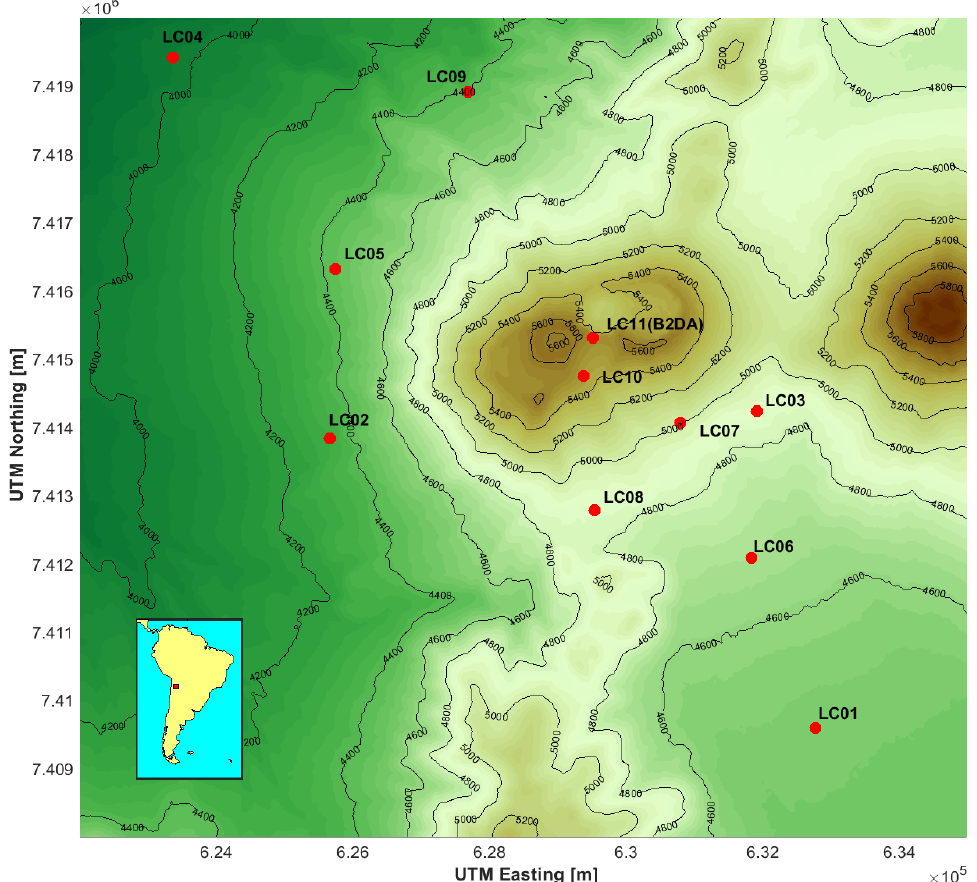
Figure 1. Location map of the Lascar volcano experiment. The red dots indicate the position of the short-period seismic stations, and the black bold text represents the corresponding names. The LC10 and LC11 (B2DA) are located eastward, near the crater of the Lascar volcano. The DEM data are a product of ASTER Global Digital Elevation Model version 3 (ASTGTM v003), these can be downloaded directly by OPeNDAP link (https://lpdaac.usgs.gov/tools/opendap/, last access: 24 February 2023). The processing of the DEM was made using